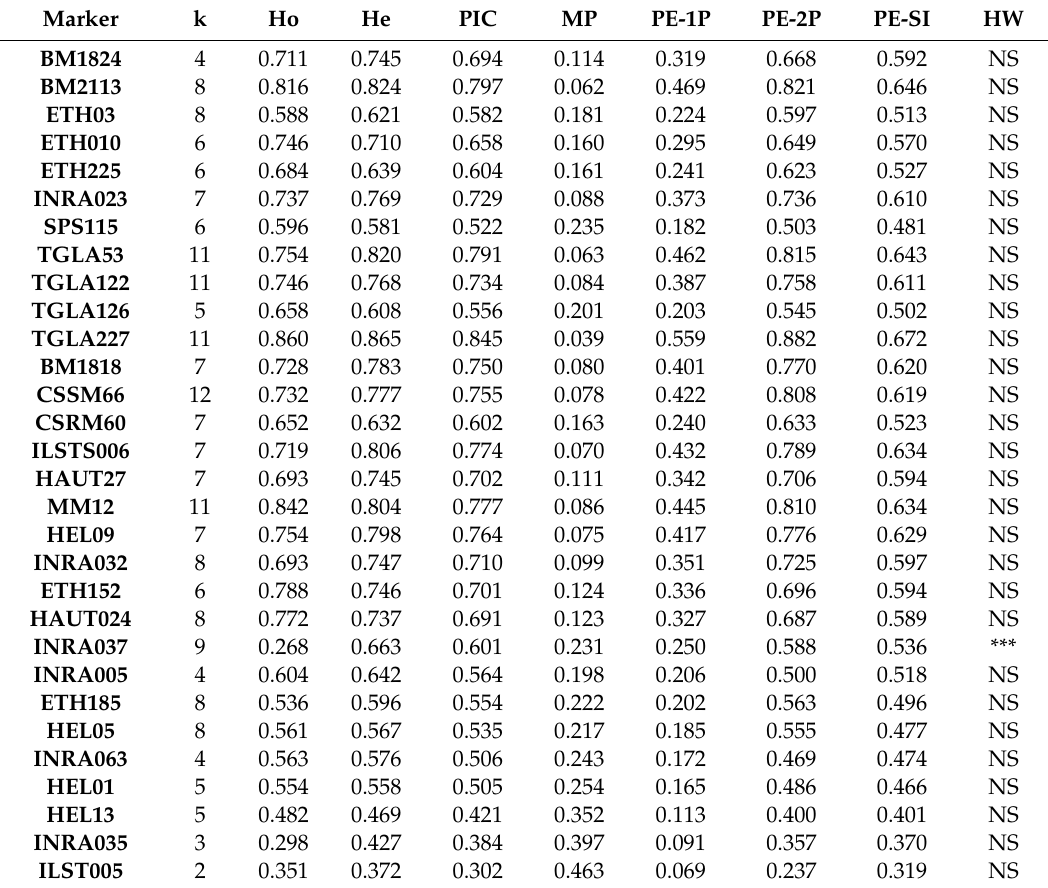
Table 1. Statistical parameters for genetic characteristics of Pirenaica breed using the panel of 30 short tandem repeat markers by ISAG-FAO